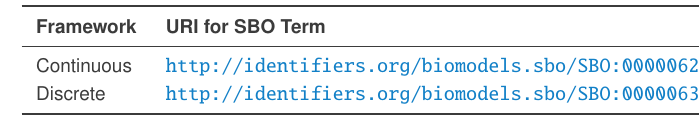
Table 15: SBO terms to specify the framework property of a Model .